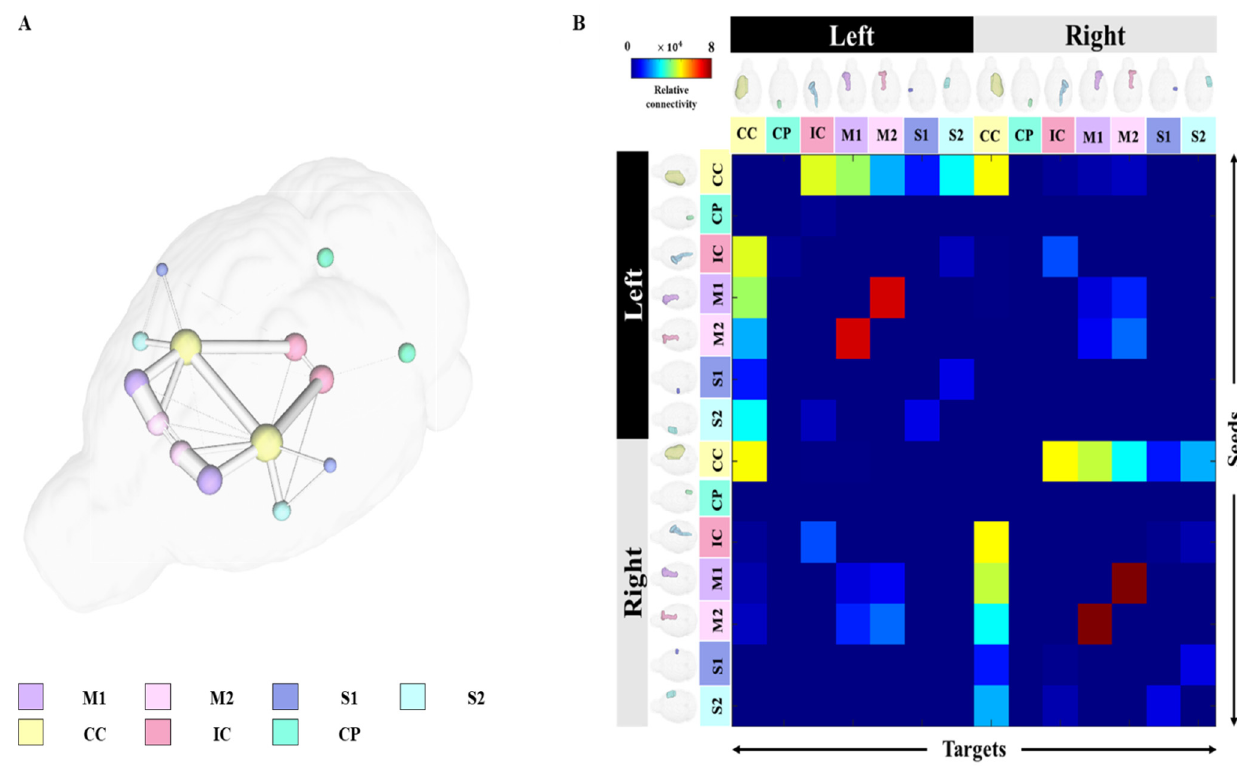
Figure 4. Results of tractography analysis between 14 anatomical regions. The connectivity between each structural region in the 3D rendered whole brain is shown in ( A ), and the label of each structural region is shown at the bottom of the figure. In addition, the connectivity matrix between each structural region was plotted using ( B ) connectivity strength color maps with the seed plotted on the left and the target plotted on top. Abbreviations: Primary motor cortex, M1; Secondary Motor Cortex, M2; Primary Somatosensory Cortex, S1; Secondary Somatosensory Cortex, S2; Corpus Callosum and Associated Subcortical White Matter, Corpus Callosum and Associated Subcortical White Matter, CC; Internal Capsule, IC; Cerebral Peduncle, CP.